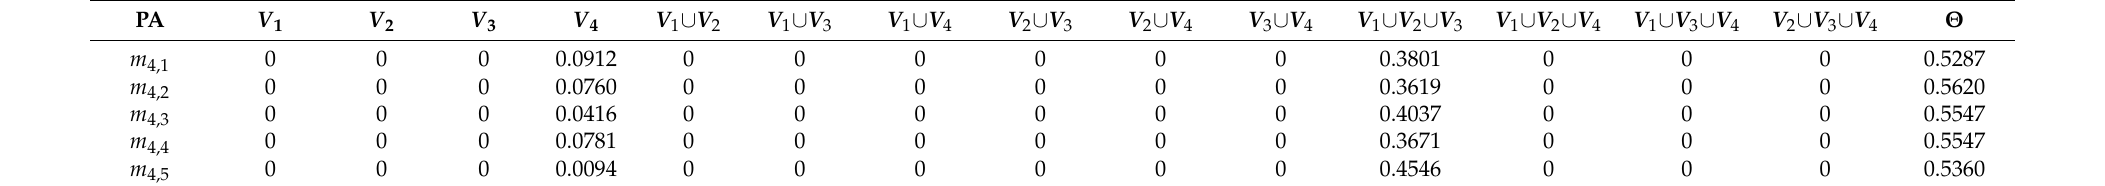
Table 5. Probability assignments of oblique crack-rest sub-classifier for an image without a